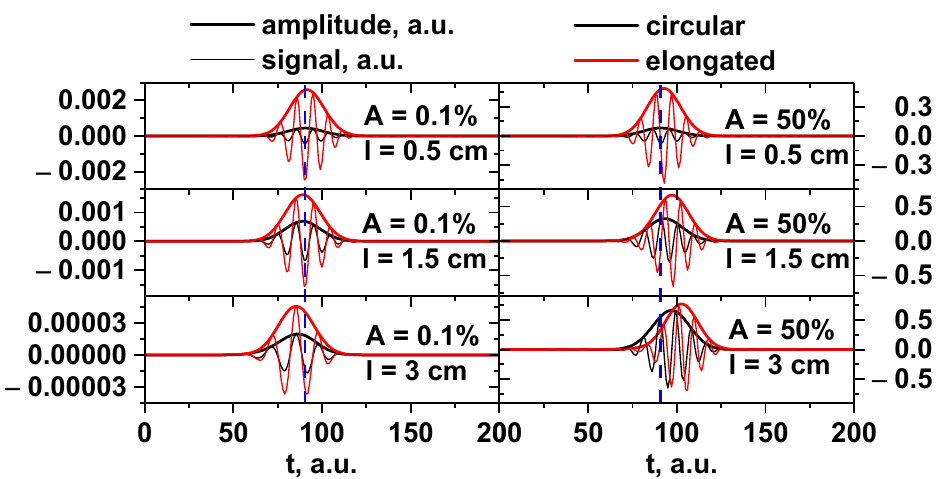
Figure 24. DBS signals (bold lines) and amplitude (regular lines) for the circular filament (black lines) and radially stretched filament (red lines): ( left ) filament amplitude of 0.1% of density at cutoff of the probing wave 48 GHz where the filament was positioned; ( right ) filament amplitude of 50%. Different filament diameters: ( top ) 0.5 cm, ( middle ) 1.5 cm, and ( bottom ) 3 cm.